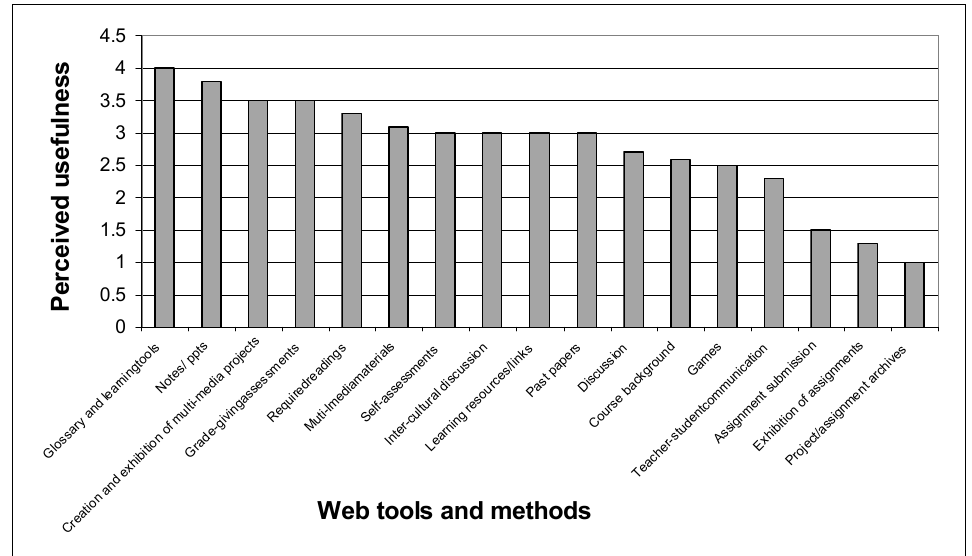
Figure 1. Ranking of perceived usefulness of the various web-assisted